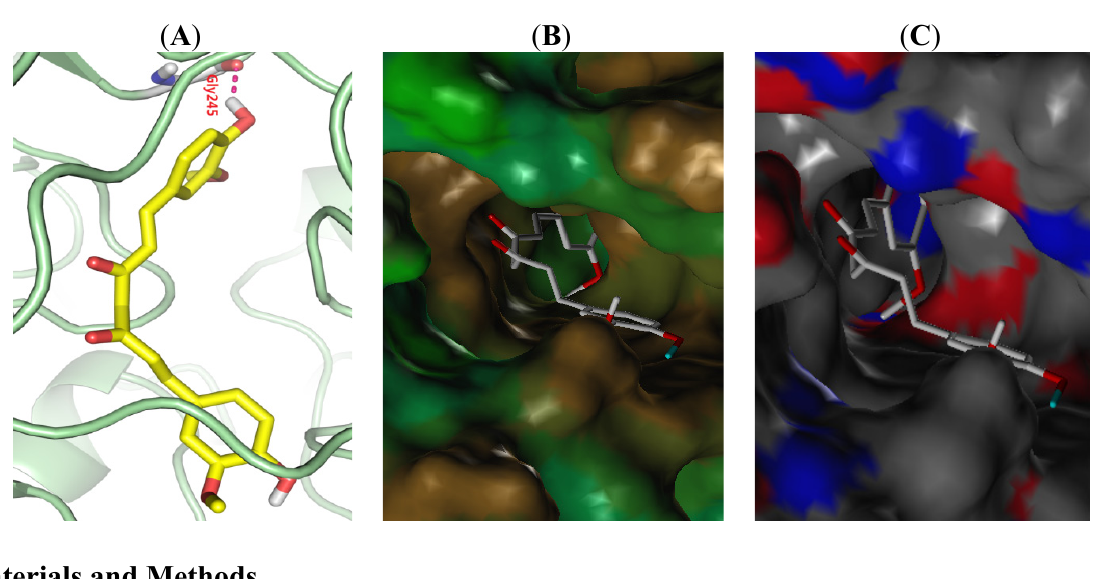
Figure 6. The binding mode between curcumin with ALDH1(A). Active site MOLCAD surface representation Liphilic potential and Hydrogen Bonding; ( B ) Brown: Hydrogen and green: Hydrophlic; ( C ) Red: Hydrogen donor and blue: Hydrogen